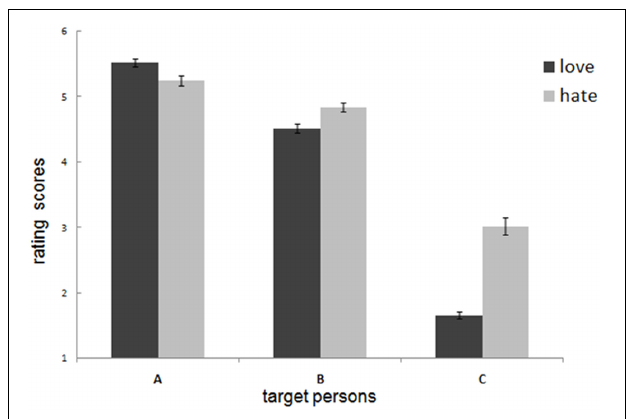
FIGURE 3 | The love and hate level of all participants in response to the 3 (targets: A, B, C) × 2 (affect: love, hate) two-ways repeated measures ANOVA revealed a significant target × affect interaction. Error bars represent +1 standard error (SE). Participants’ degree of love for A (excellent and high similarity with the participants) was still higher than hate after negative events occurred, but the tendency for B (excellent and moderate similarity) and C (low excellence and low similarity) is